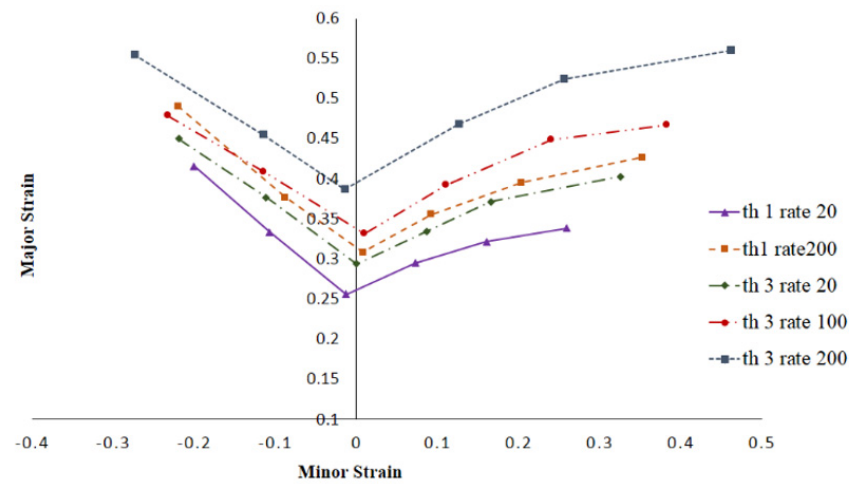
Figure 15. FLDs at various speeds for 1 mm- and 3 mm-thick sheets.